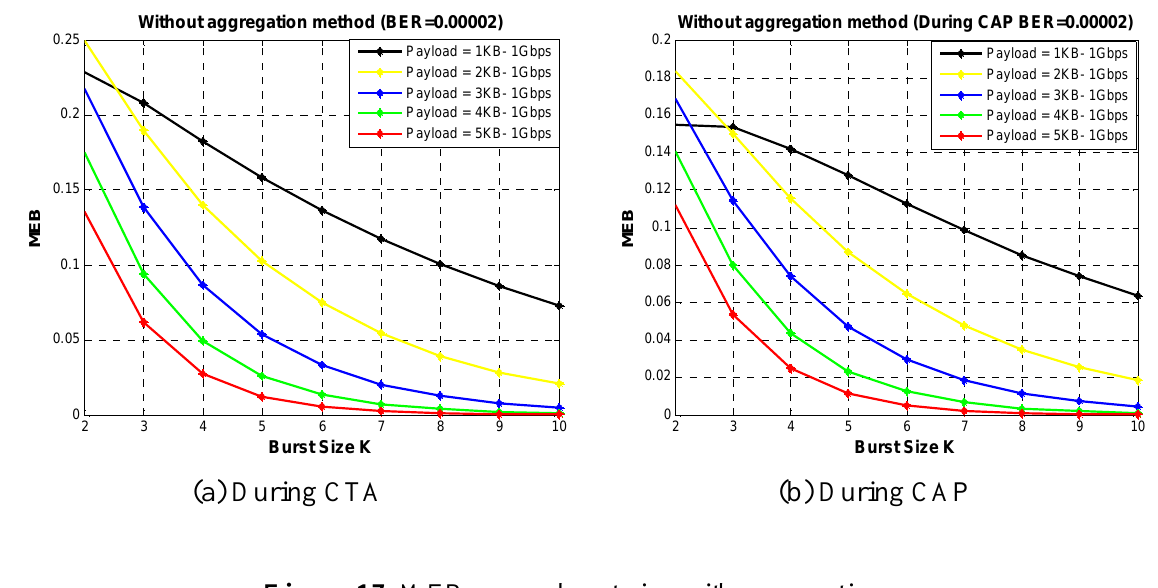
Figure 16. MEB versus burst size without aggregation.